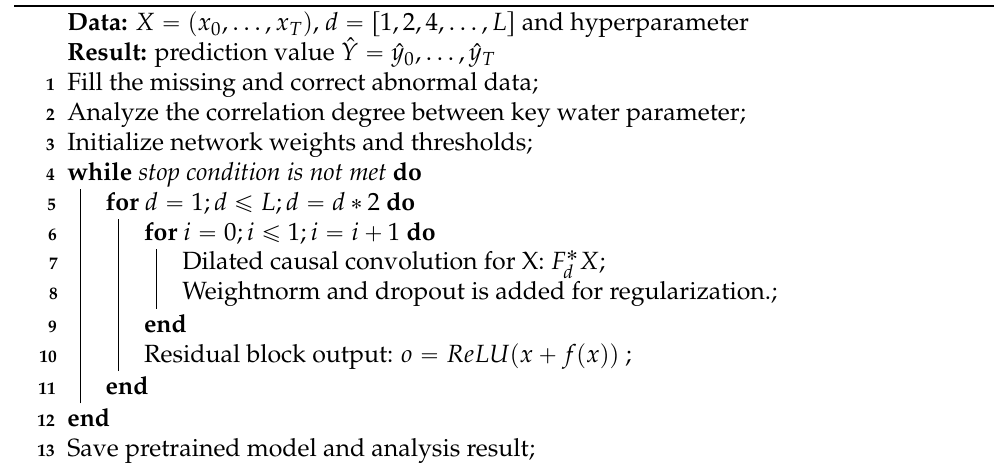
Algorithm 1: Description of water quality prediction